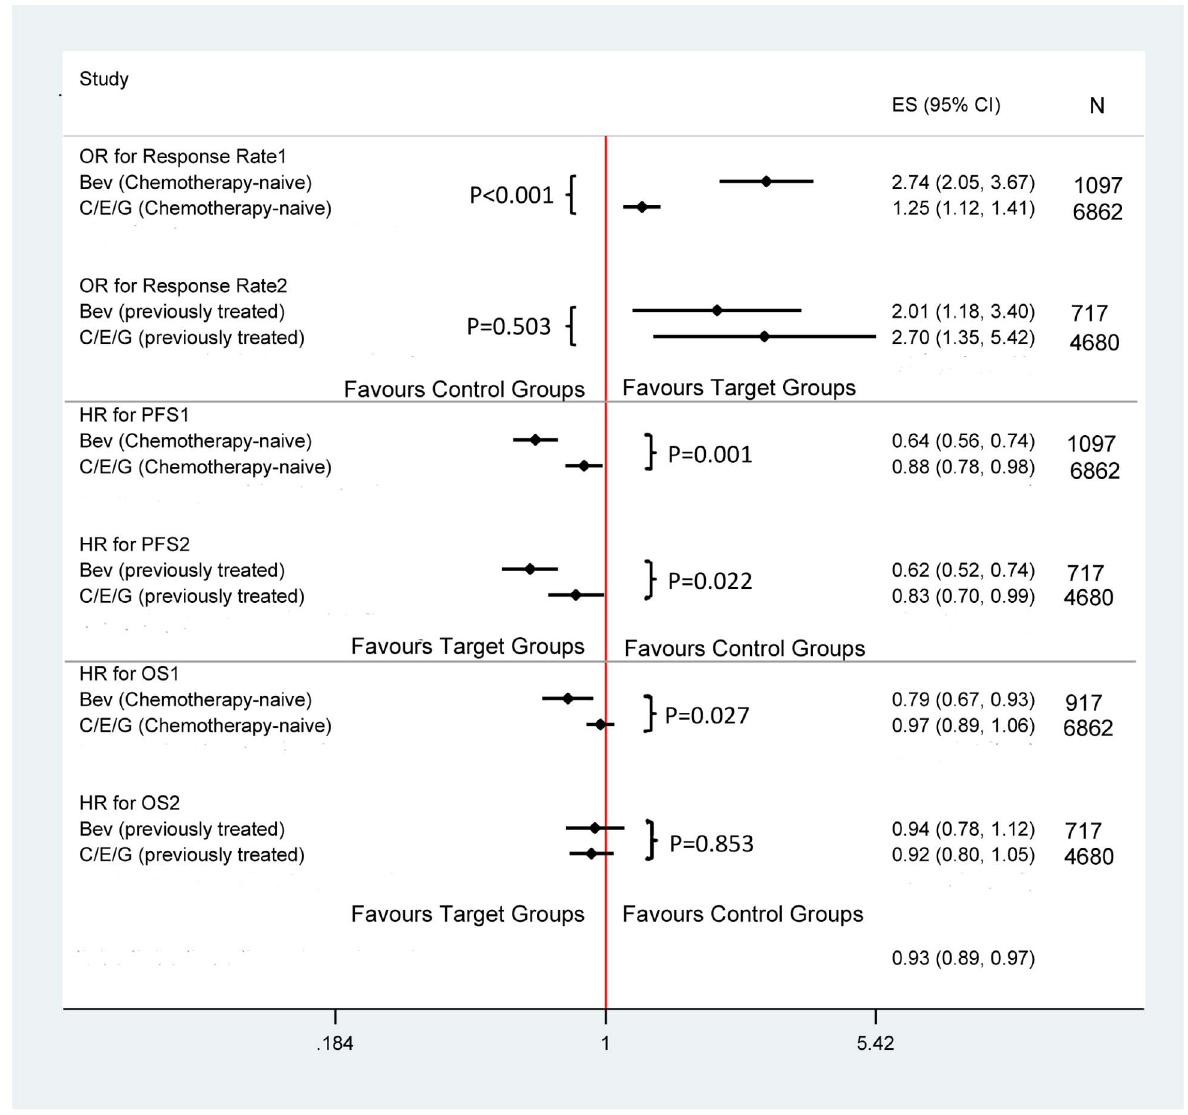
Figure 4. Response rate, PFS, OS of Bevacizumab versus other targeted drugs in EGFR untested NSCLC patients.